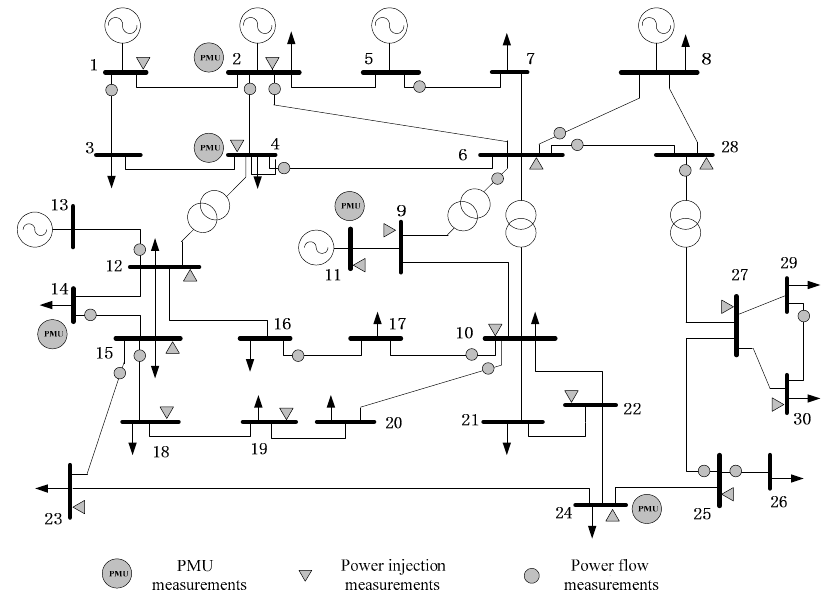
Figure 13. Simulation measurement configuration of the IEEE 30 bus system.